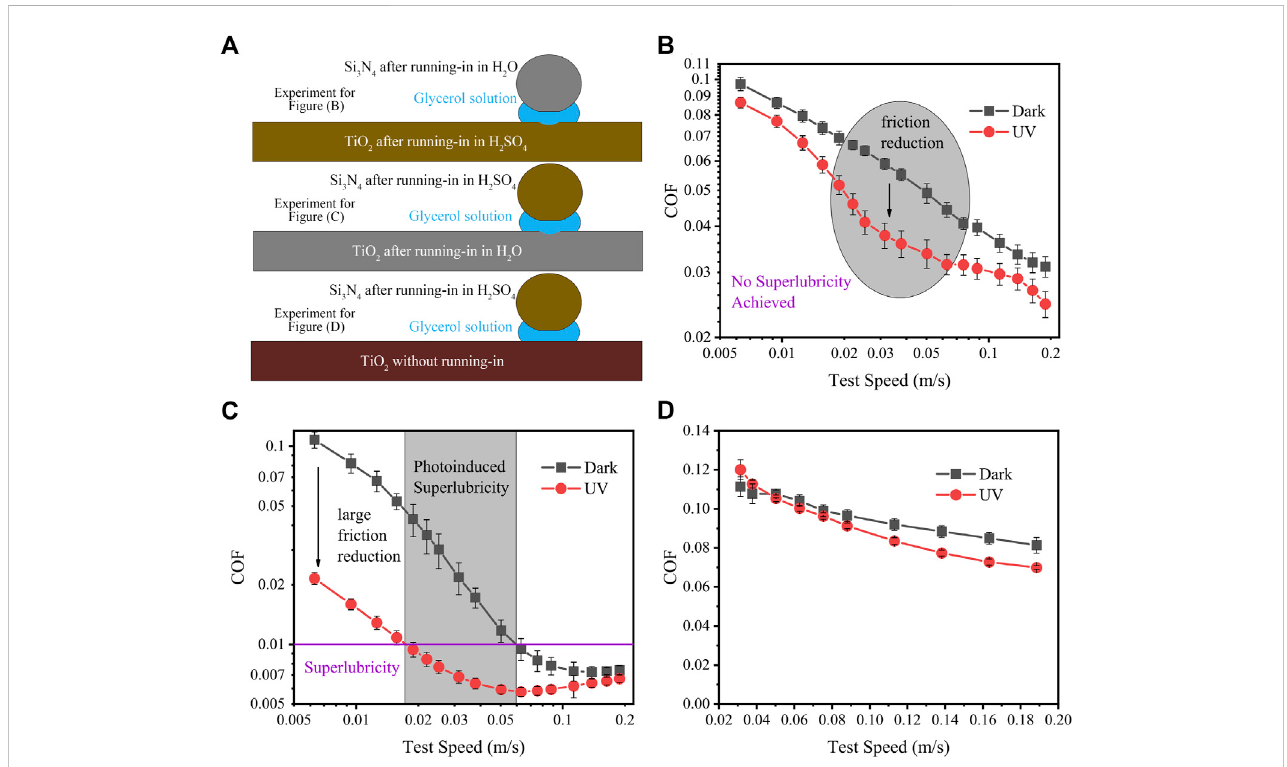
FIGURE 11 (A) Illustrations for the friction test with and without ultraviolet treatment at different test speeds in 70% glycerol solution (B) with Si 3 N 4 balls after running-in in deionized water and TiO 2 after running-in in H 2 SO 4 (pH = 1); (C) with Si 3 N 4 balls after running-in in H 2 SO 4 (pH = 1) and TiO 2 after running-in in deionized water; and (D) with Si 3 N 4 balls after running-in H 2 SO 4 (pH = 1) and TiO 2 without